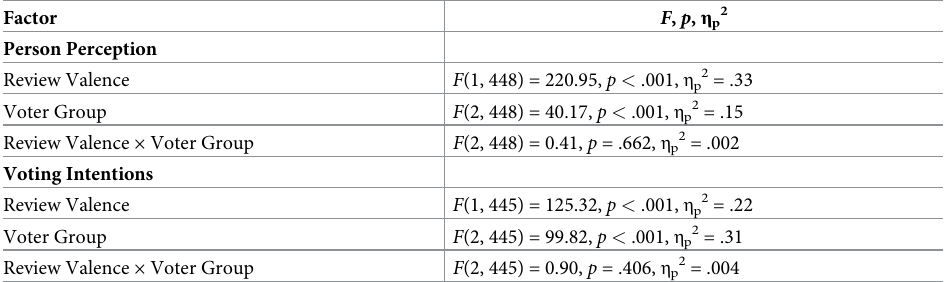
Table 3. Main effects and interactions for additional outcome measures.